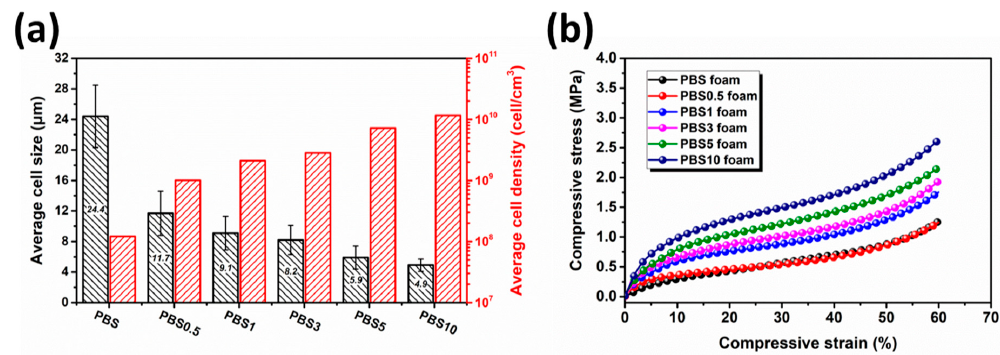
Figure 8. Characterization of neat PBS foams and PBS / CB nanocomposite foams: ( a ) average cell size and cell density; ( b ) compressive strain-stress curves.